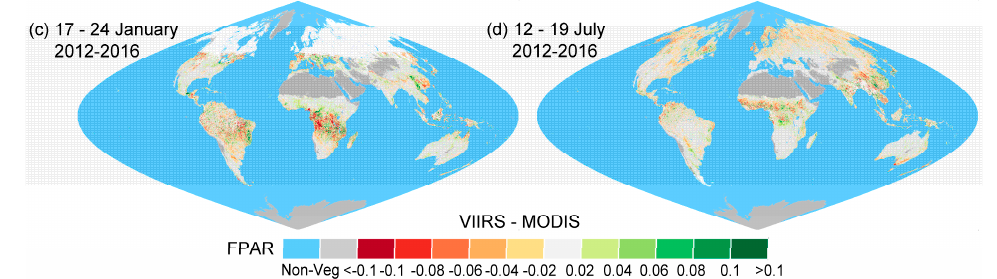
Figure 2. The global spatial pattern of mean ( a , b ) LAI difference and ( c , d ) FPAR difference (VIIRS-MODIS) in each 10 km × 10 km grid from 2012 to 2016 at two observation dates (17–24 January and 12–19 July). The white color indicates invalid LAI/FPAR values calculated from QC layers as mentioned in Section 3.2. An equal-area sinusoidal projection is used here.